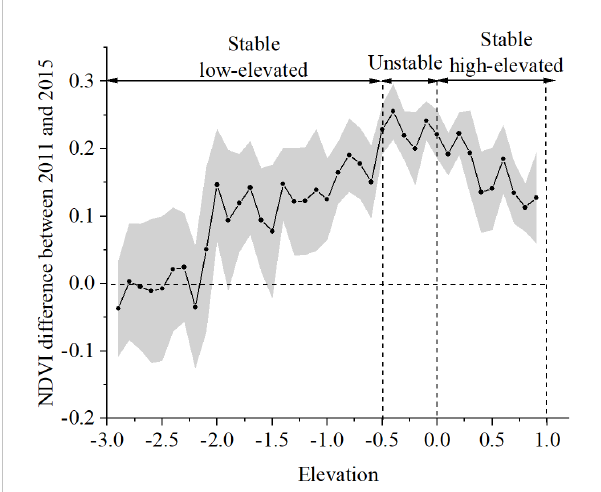
FIGURE 7 Plot of NDVI difference between 2011 and 2015 and elevation in 2011. Black dots with gray standard deviation denote the mean NDVI change within the 0.1 m elevation interval. The boundaries between the stable and unstable zone in elevation refer to Figure 6A.